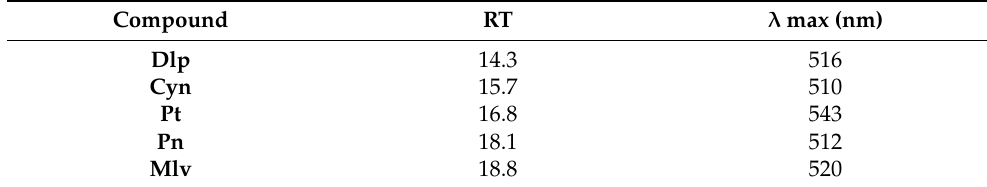
Table 6. Chromatographic retention times and maximum wavelengths of anthocyanins.